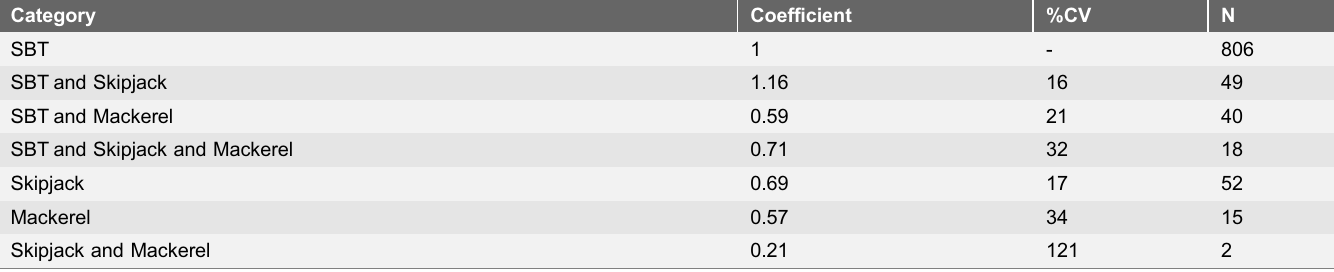
Table 2. Estimates of coefficients (on the response scale) for the targeting covariate treated as a factor relative to